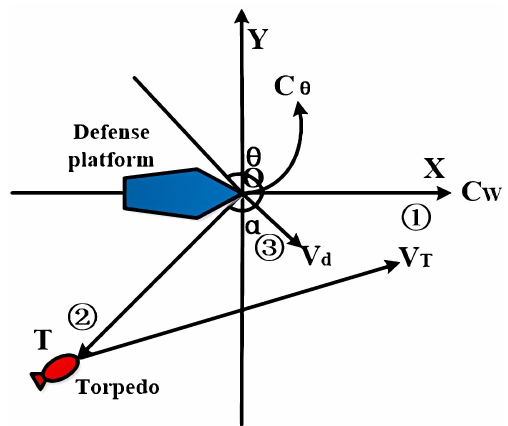
Figure 4. The acoustic decoy deployment scheme.